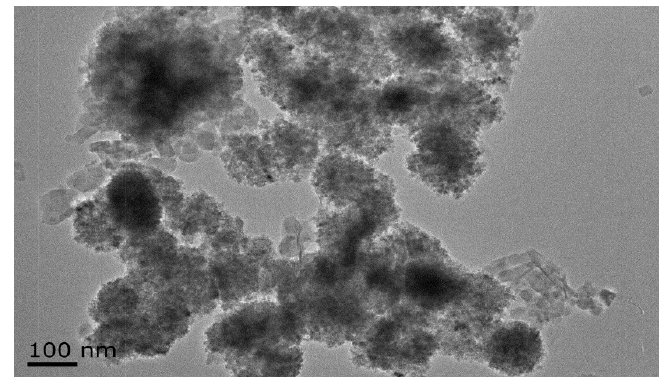
Figure 1. TEM image of the magnetite PB nano-composites.